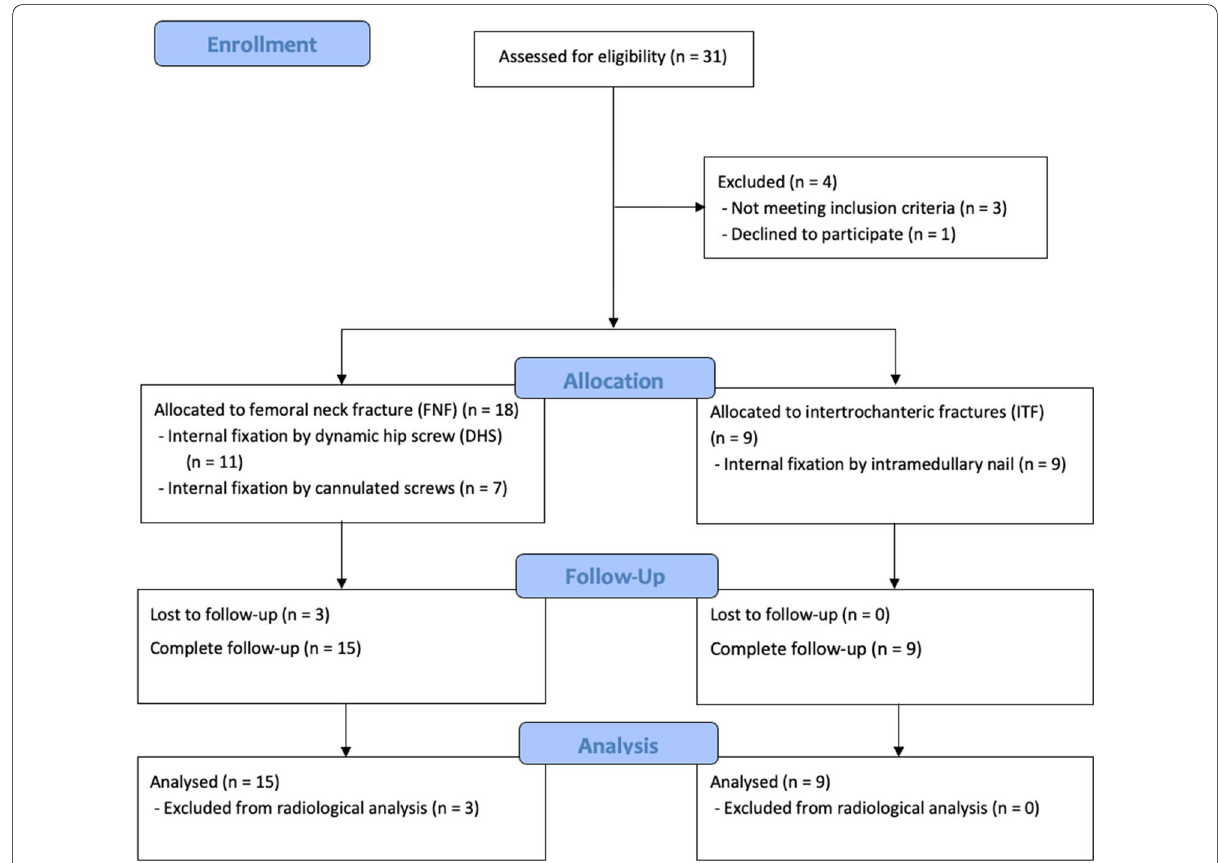
Fig. 1 Flow chart of patient